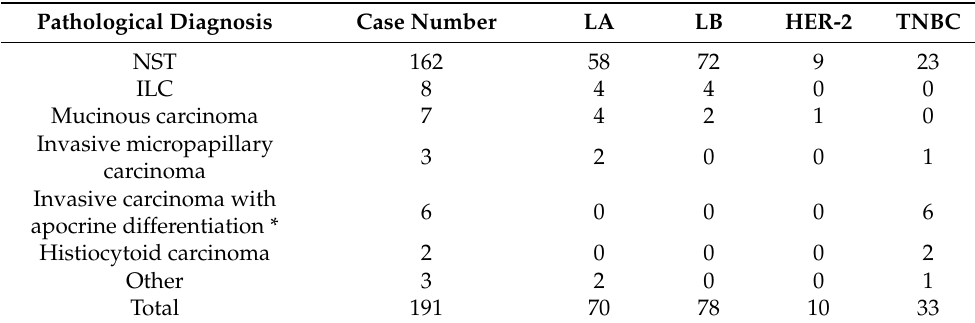
Table 2. Pathological diagnoses of breast cancers (n = 191). Pathological